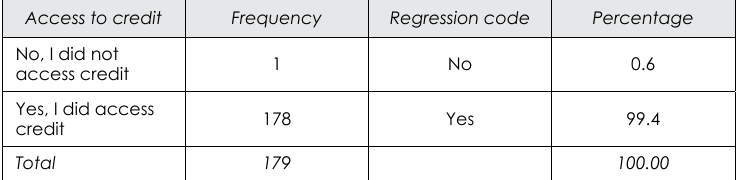
Accessibility of credit and no credit accessibility Access to